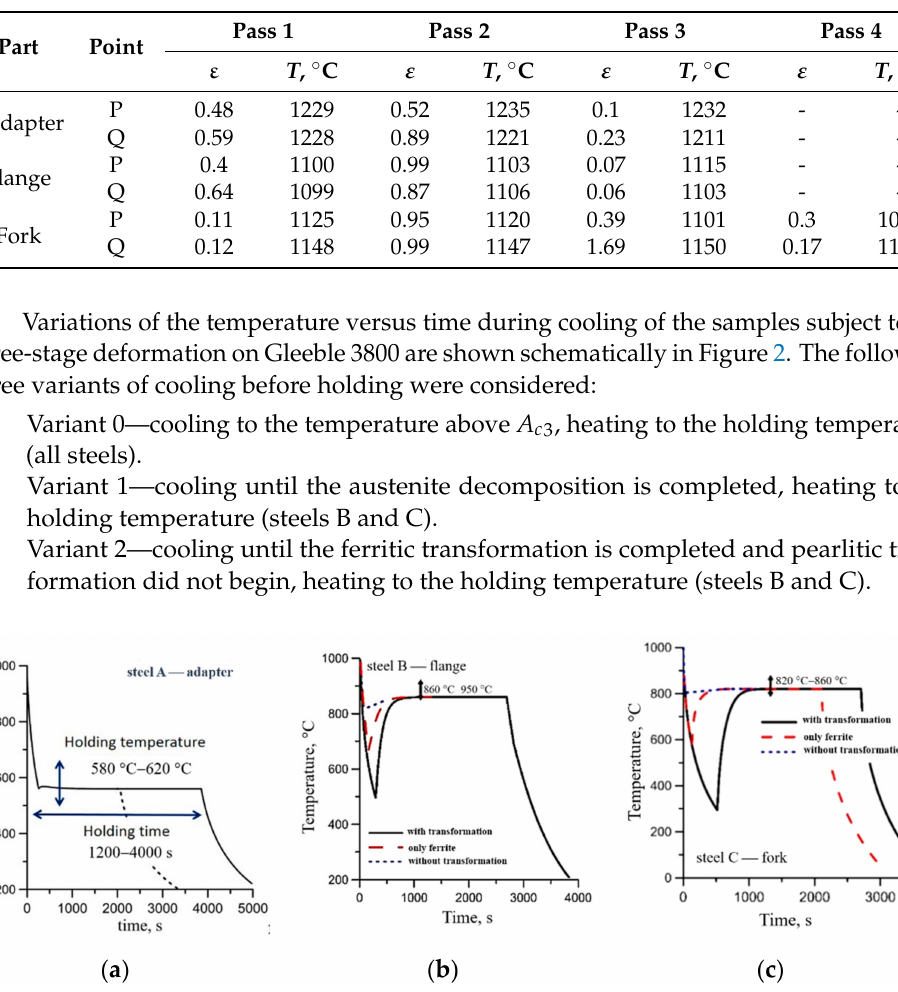
Figure 2. Thermal cycles in points P during cooling of the investigated forgings: ( a ) annealing of the adapter, ( b ) normalization of the flange, ( c ) quenching and tempering of the